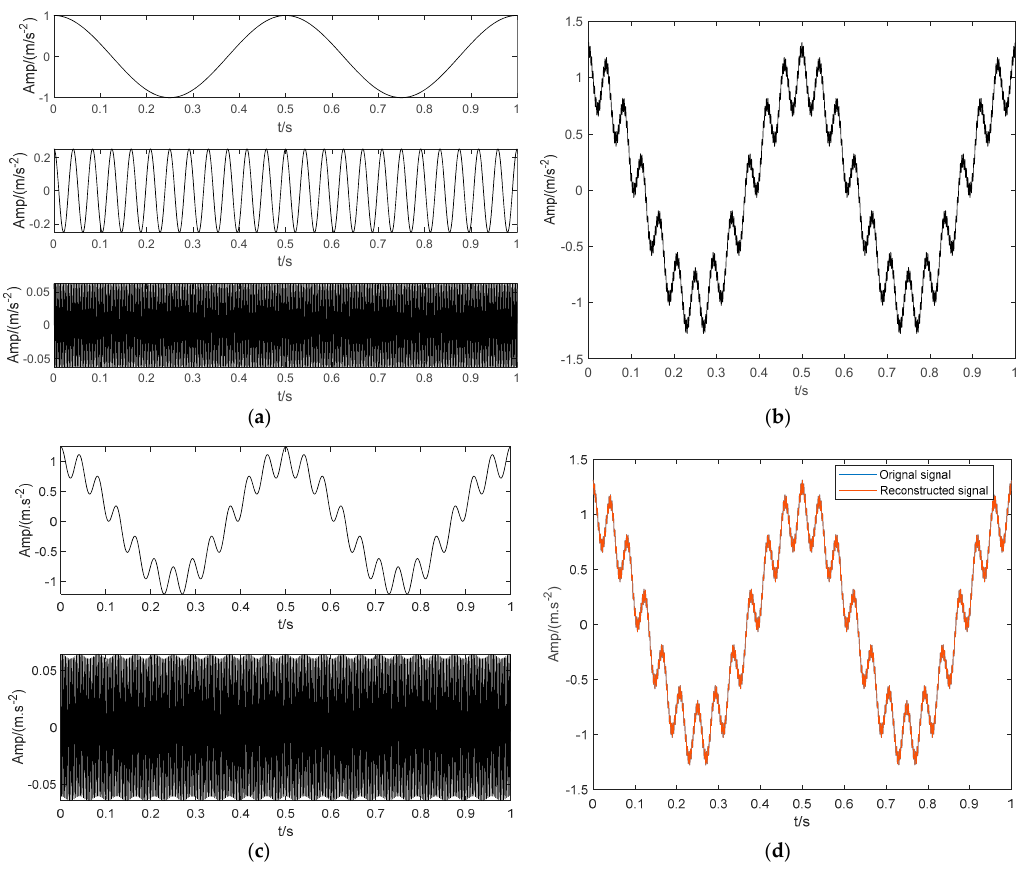
Figure 1. The singularity analysis of IMF components. ( a ) Sinusoidal harmonics. ( b ) Mixed signal. ( c ) Modes. ( d ) The reconstructed signal.